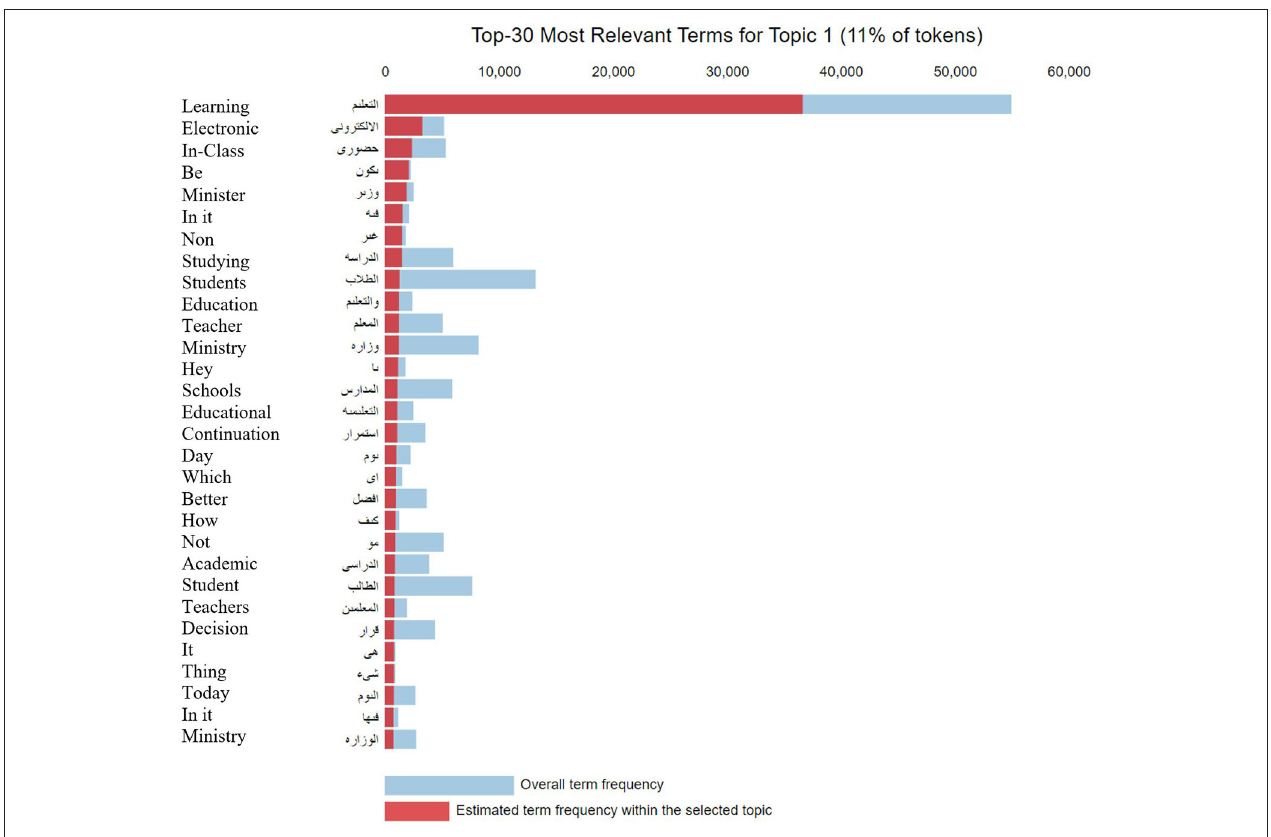
Figure 4 | The top 30 most relevant keywords/key terms by frequency (topic